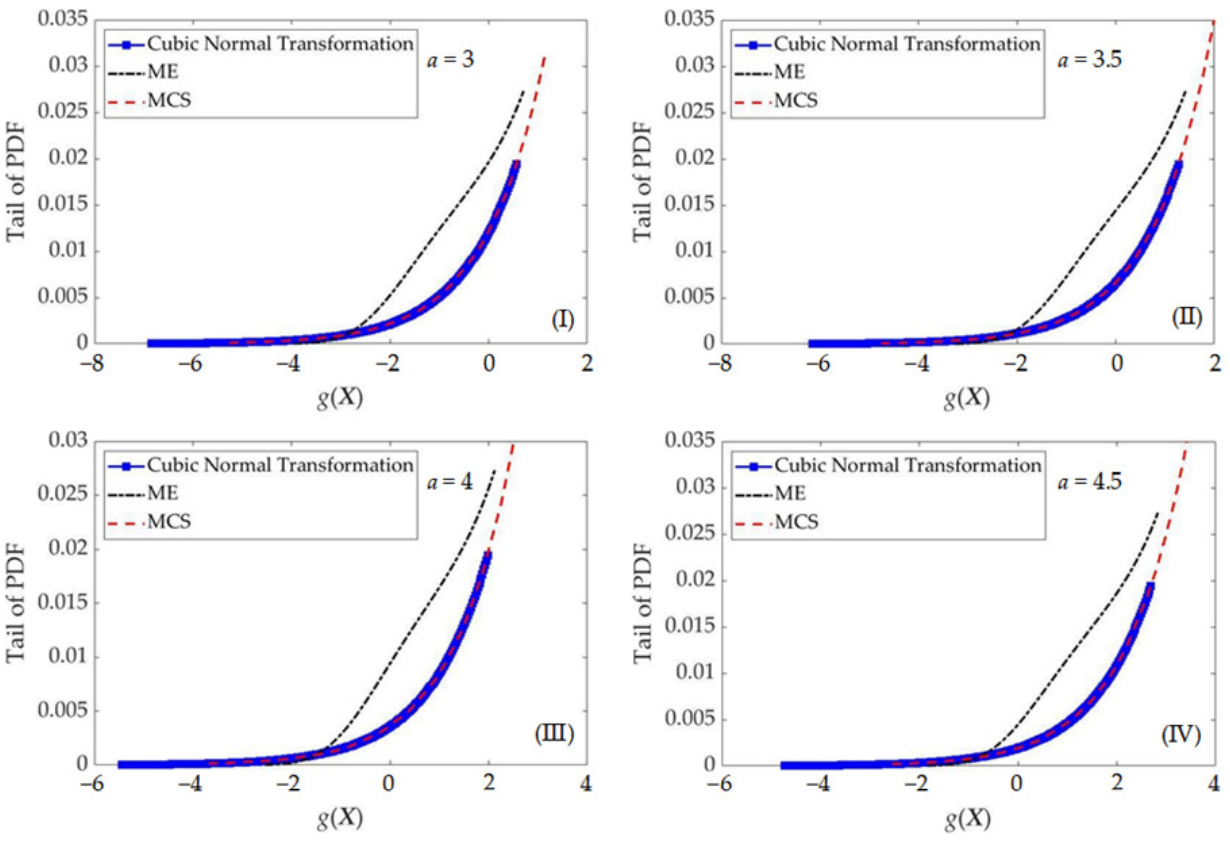
Figure 3. Tails of PDFs approximated by the different methods in Example 1.